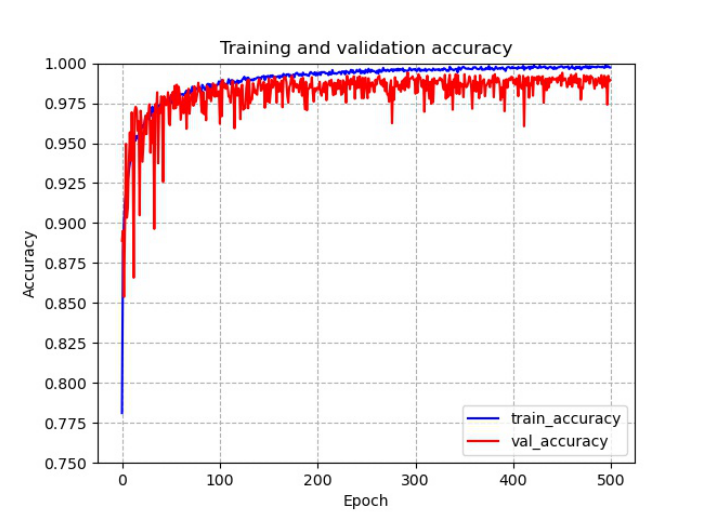
Figure 11. Accuracy of the network for tool wear status diagnosis. (2) Max-AVG pooling multilayer feature fusion network for tool wear diagnosis.